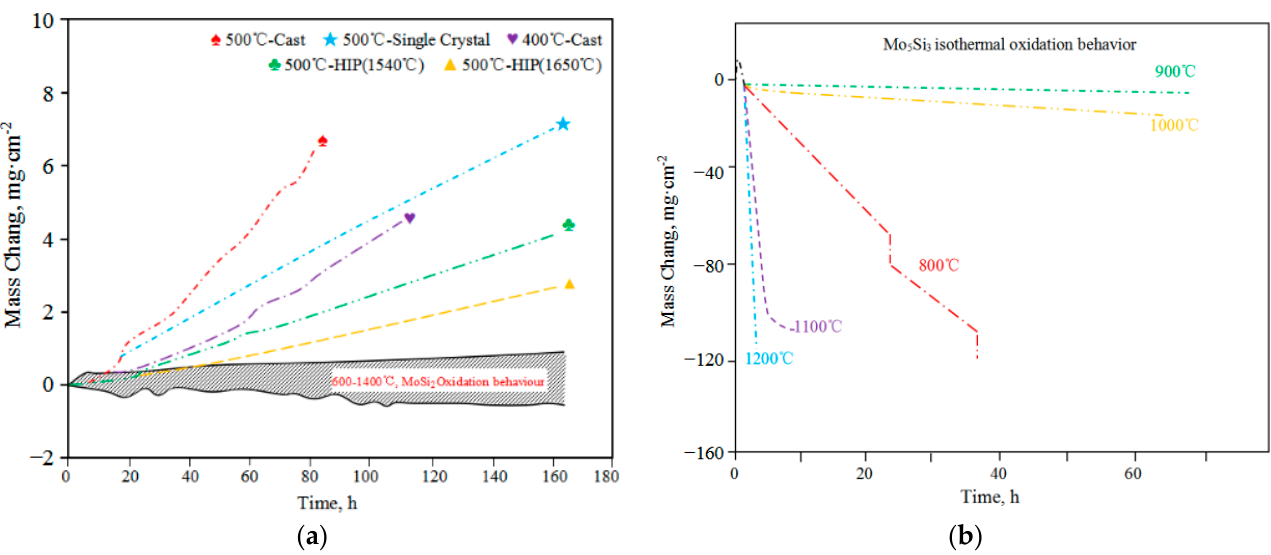
Figure 4. Oxidation of Mo-Si intermetallic compounds: ( a ) isothermal oxidation of MoSi 2 with different preparation processes in the range of 40 to 1400 °C; ref. [39]; ( b ) isothermal oxidation of Mo 5 Si 3 in the temperature range of 800 to 1200 °C [40].